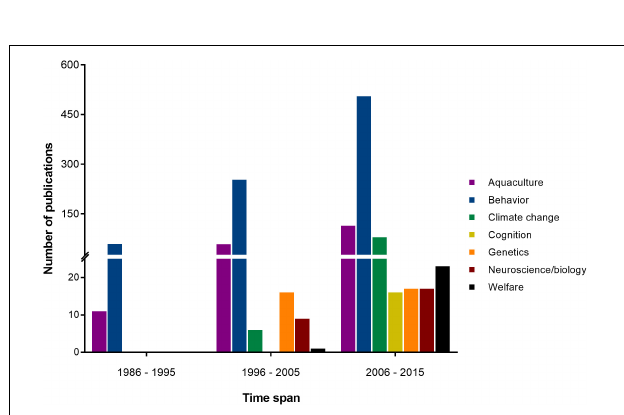
FIGURE 1 | Total number of publications on cephalopods per quinquennium that appeared in a genus-name search of the Zoological Record during the 20th century (adapted from Borrelli and Fiorito, 2008). Bar colors highlight different paces of research (see text for details).